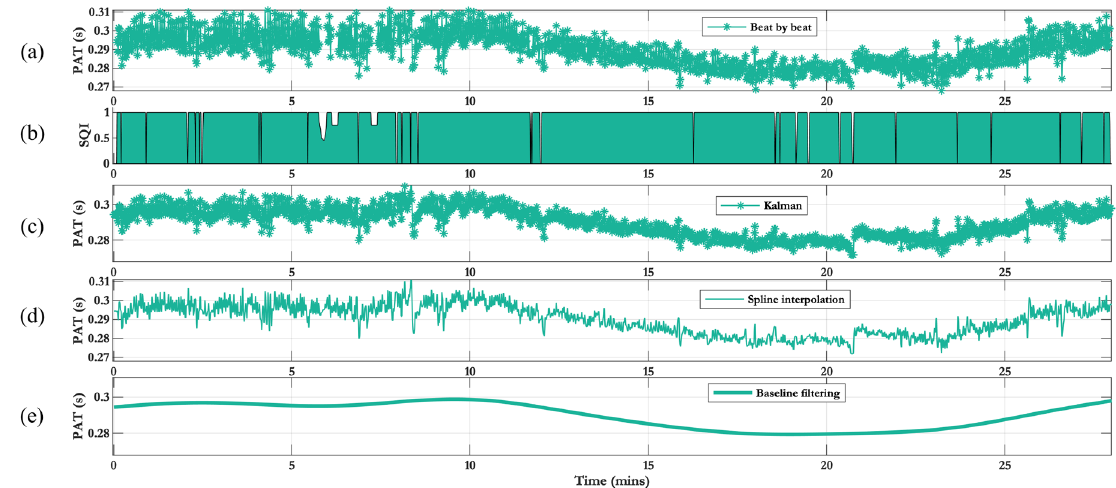
Figure 10. Overview of the PAT processing steps. ( a ) Beat by beat PAT time series, ( b ) SQI of the PAT time series, ( c ) Kalman filter output, ( d ) Spline interpolation of signal at 60 Hz, ( e ) Extracted baseline changes of